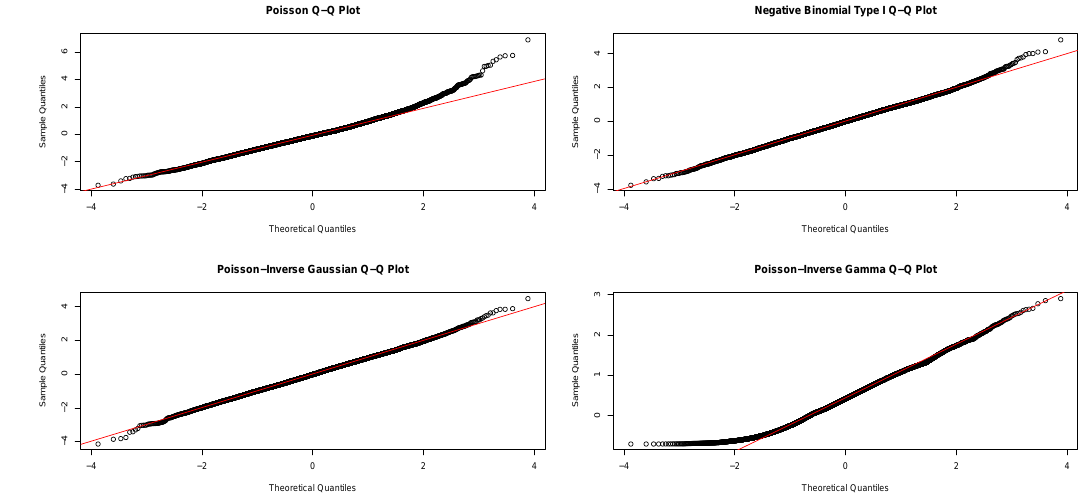
Figure 1. Normalized quantiles for the Poisson regression model & the NBI, PIG, and PIGA regression models with varying